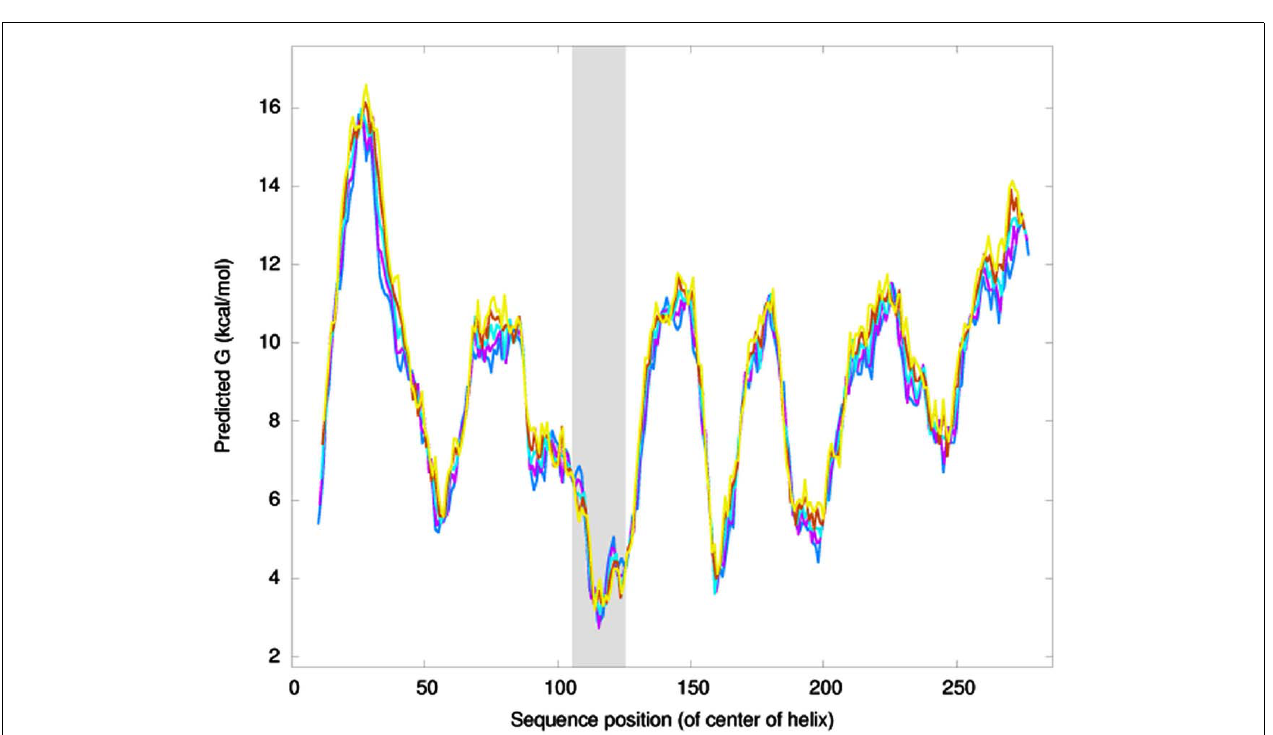
FIGURE 3 | NSVc4 transmembrane domain prediction. Prediction of transmembrane domain was carried out with the ∆ G prediction